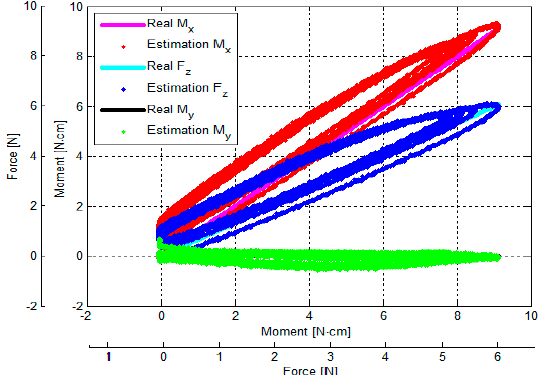
Figure 15. Comparison between real ( F z , M x ) and estimated ( F z , M x ): external force was applied to and released from point ① obtained by the sensor calibration device as shown in Figure 12.